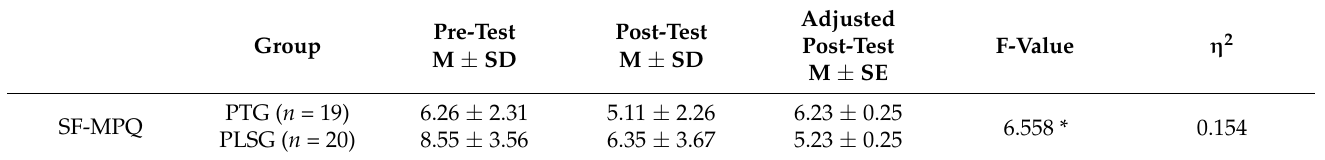
Table 2. Analysis of covariates of changes in the subjective pain level for each